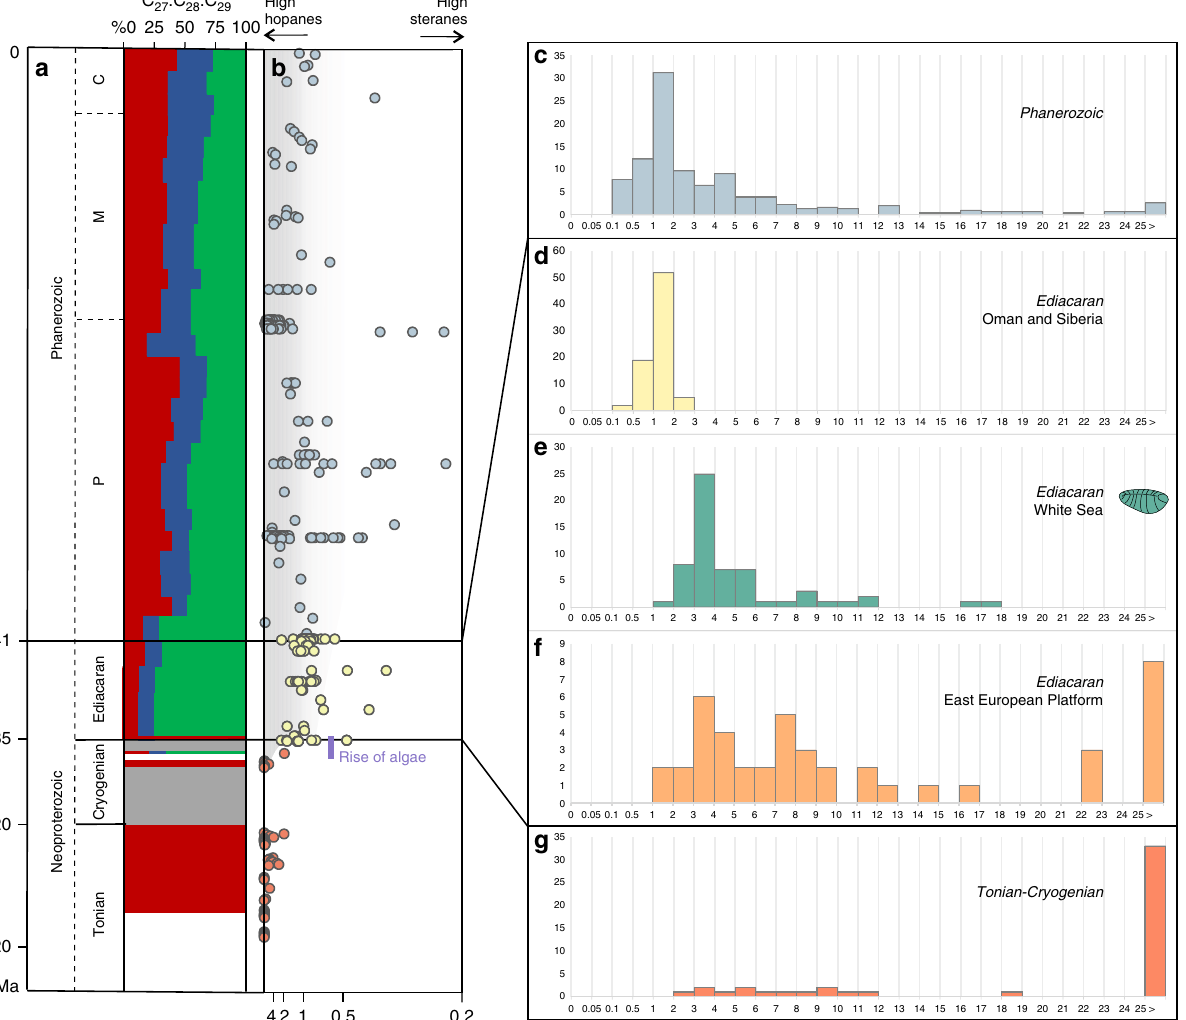
Fig. 2 Timeline through the Neoproterozoic and Phanerozoic and abundance information for hopanes and steranes. a The relative abundance of the sterane homologues cholestane (C 27 , green), ergostane (C 28 , blue) and stigmastane (C 29 , green). Size of the coloured areas re fl ects relative sterane abundances. b Evolution of the relative abundance of bacterial hopanes over eukaryotic steranes (H/S) through time (orange = Tonian and Cryogenian; yellow = Ediacaran (data from Oman and Siberia); blue = Phanerozoic); the scale goes from H/S ~ ∞ (with no steranes detected) to H/S = 0.25, converted from the S/H ratio values from 0 to 4 in Brocks et al. 15 . Histograms showing the abundance distribution of H/S values for different periods and locations: c Phanerozoic biomarker data reported in the literature; d Ediacaran of the South Oman Salt Basin and the Siberian platform; e Ediacaran of the White Sea area; f previous biomarker analyses on the Ediacaran of the EEP (localities are marked as orange circles on Fig. 1); g Tonian and Cryogenian biomarker data reported in the literature. Data from the EEP from Pehr et al. 17 , data for the White Sea this study, all other data recalculated from Brocks et al. 15